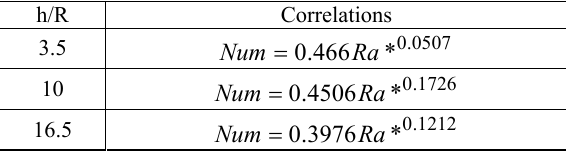
Figure 14. Mean Nu versus heat flux with different depth/radius ratios.